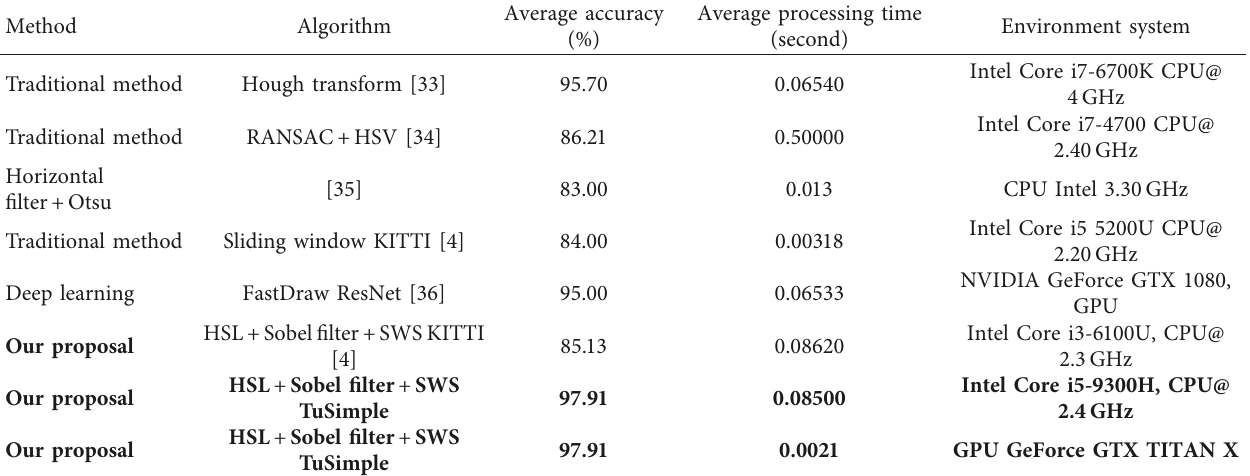
Table 5: Result of comparison lane detection algorithm.